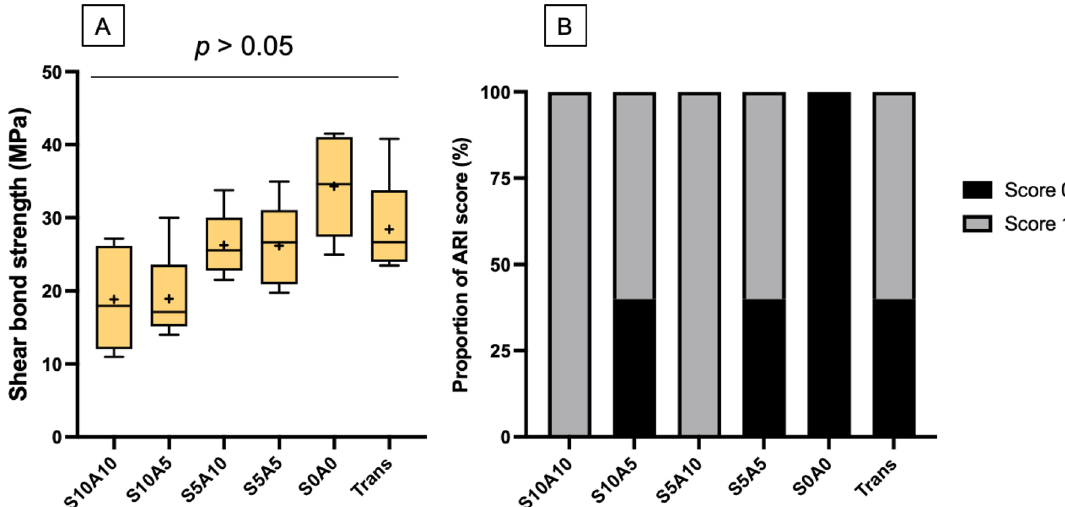
Figure 3. ( A ) Enamel shear bond strengths of materials. The boxes represent the first quartile (Q1) to the third quartile (Q3), the horizontal lines in the box represent the median, the whiskers represent the maximum and minimum values, and “ + ” represents the mean value (n = 5). ( B ) Proportions of the adhesive remnant indices (ARI scores) of the specimens in each group. The ARI scores of 2 and 3 were not detected from the specimens.